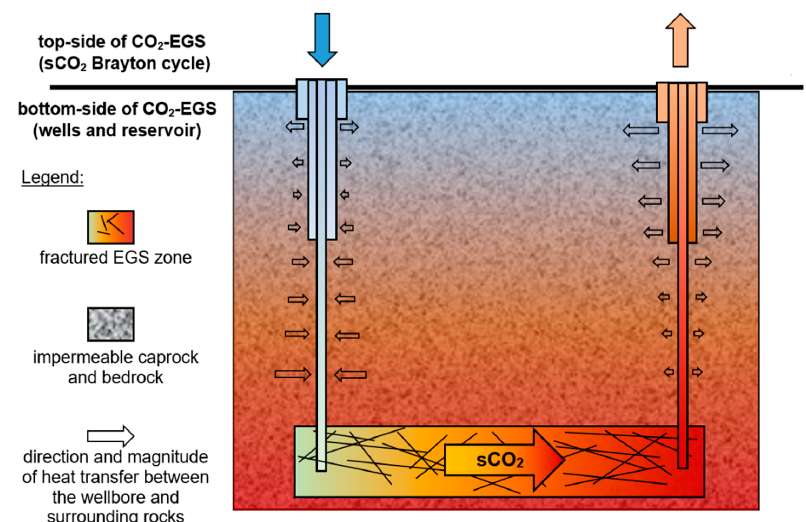
Figure 6. Schematic drawing of the single-channel EGS model.